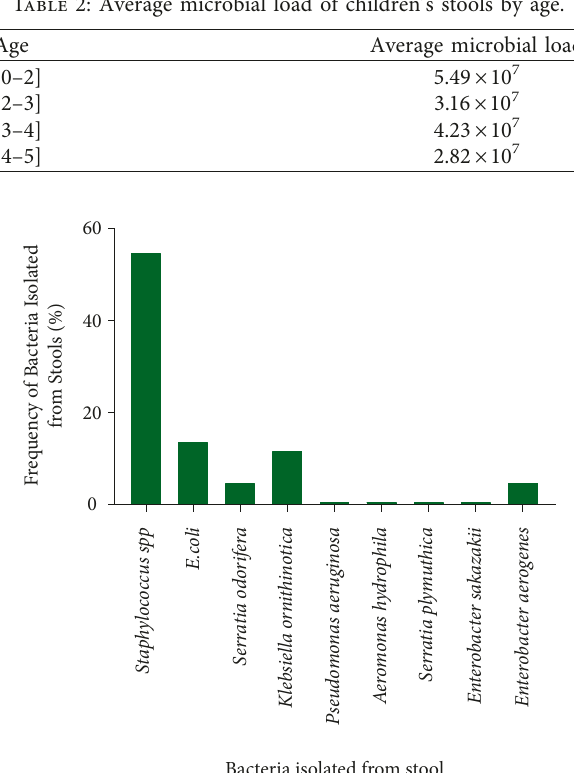
Figure 1: Overall distribution of strains isolated from stool.